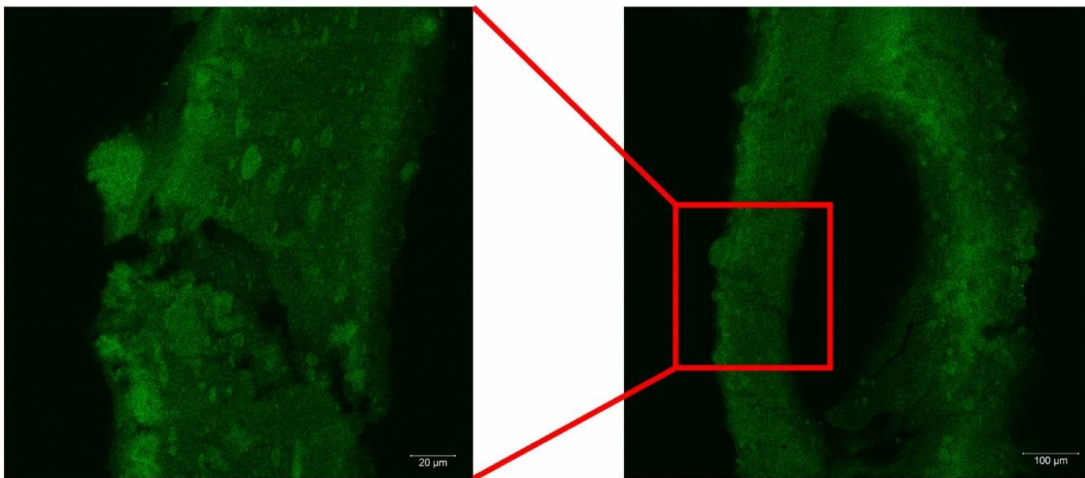
Figure 2. Laser scanning confocal microscopy images of alginate/chitosan/HNTs gel beads. Note that Alginate was labelled with 5-(4,6-dichlorotriazinyl) aminofluorescein